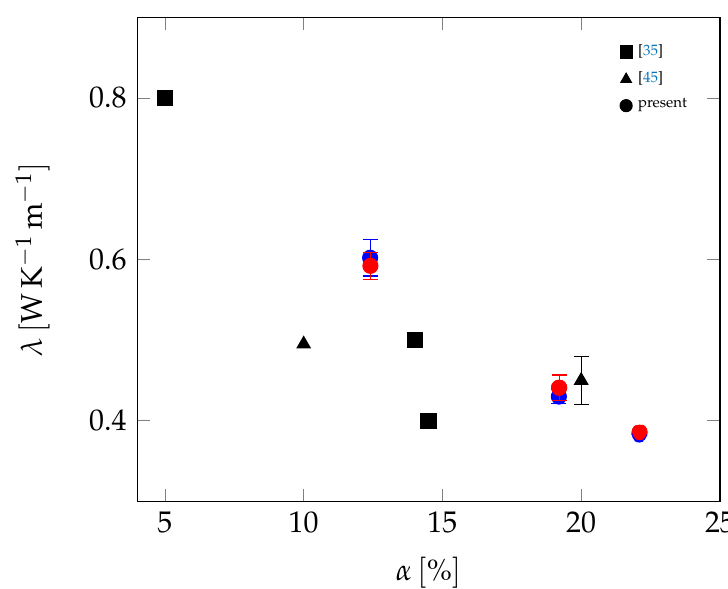
Figure 12. Comparisons of the present estimations for the thermal conductivities for the solid (blue) and liquid (red) state with similar studies (black data mean that only an unique value has been given, without specifying the physical state (solid or liquid)).